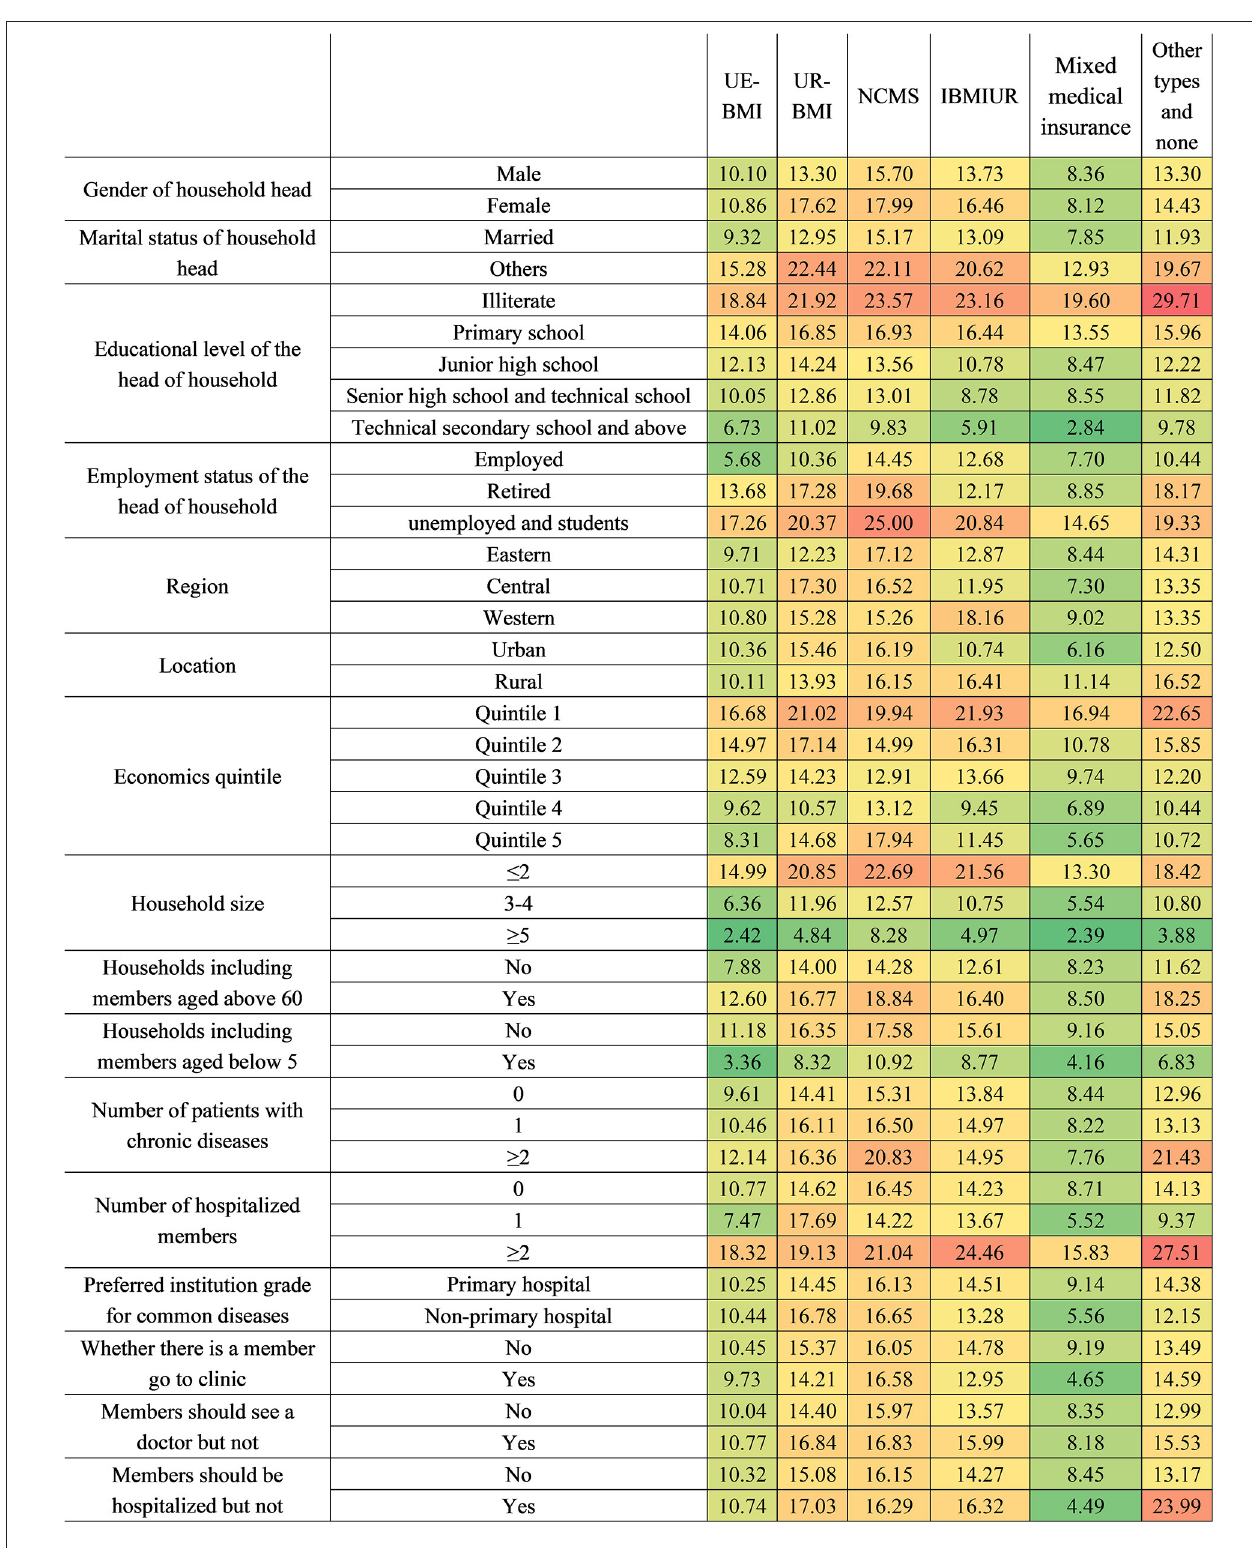
FIGURE 8 | The CHE standardized rate by different health insurance systems. IBMIUR: Integration insurance refers to other basic medical insurance types, which integrate either URBMI and NCMS or UEBMI, URBMI, and NCMS. Mixture medical insurance: It refers to participants covered by basic medical insurance and commercial insurance at the same